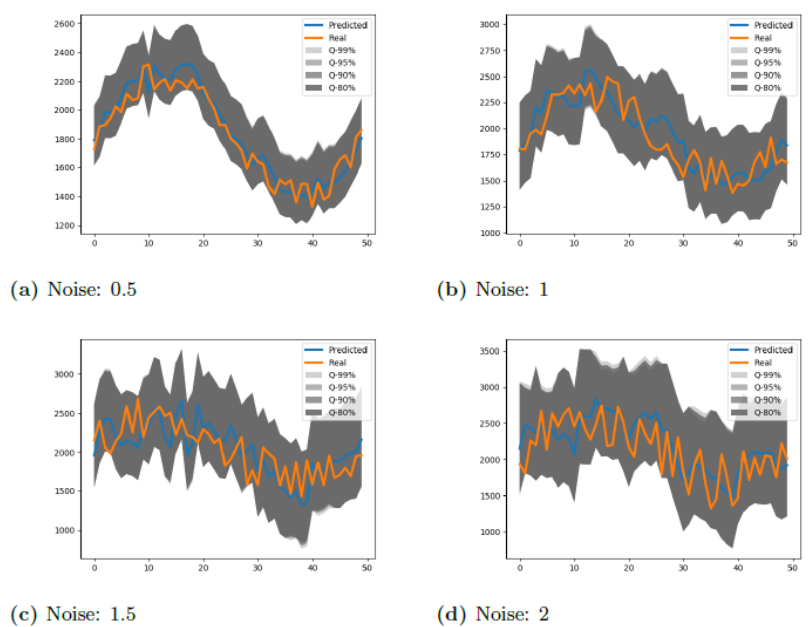
Figure 6. The result of interval prediction for random period data.